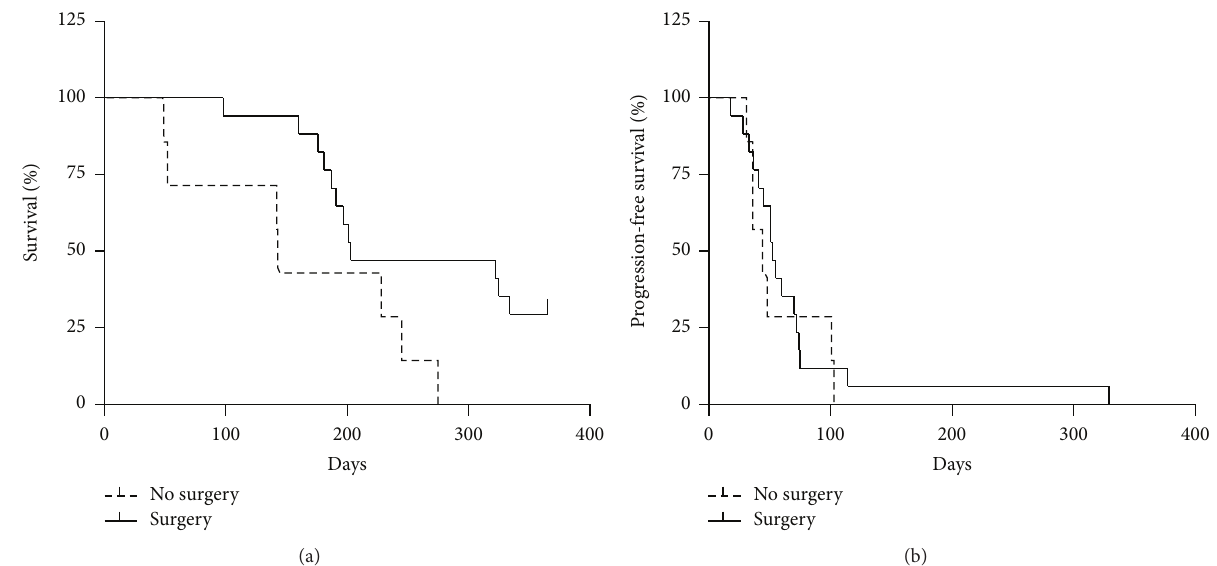
Figure 2: Kaplan-Meier plots of overall survival (a) and progression-free survival (PFS, (b)) of patients with anaplastic thyroid cancer who underwent total thyroidectomy (-) versus no thyroid surgery (--) ( 𝑃 < 0.05 ).